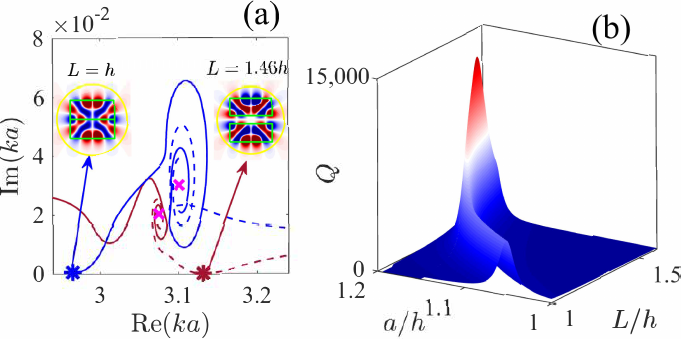
Figure 8. ( a ) Evolution of the higher lying TE resonances in traversing with the distance between the disks for a / h = 1.17. ( b ) The Q factor vs the distance between the disks L / h and their aspect ratio a / h